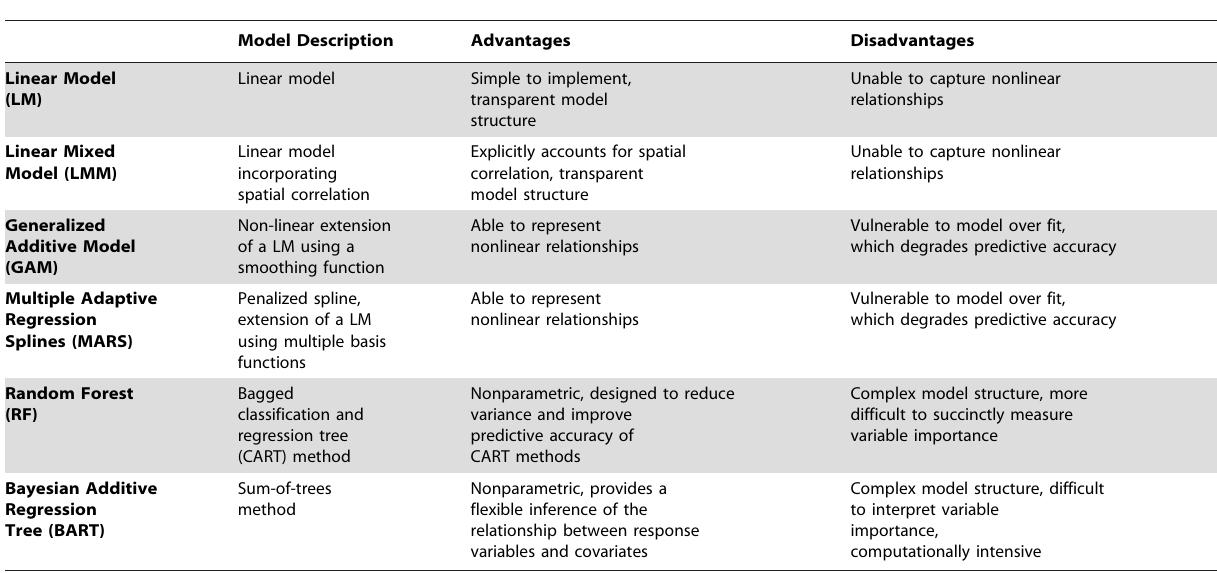
Table 1. Summary of model structures, strengths and weaknesses.